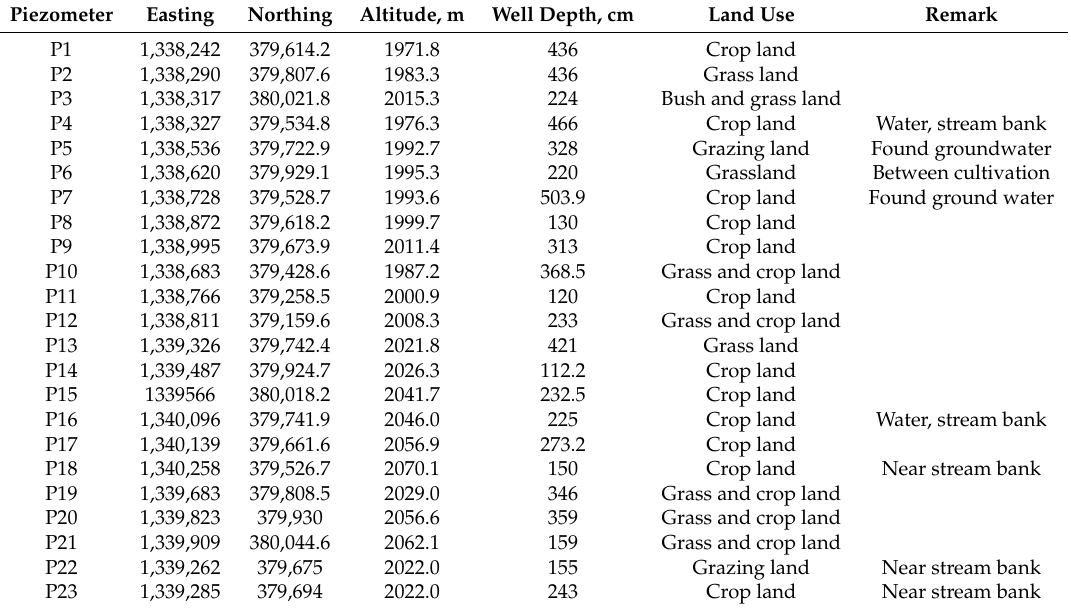
Table A2. Properties of the piezometers in the Gomit watershed.